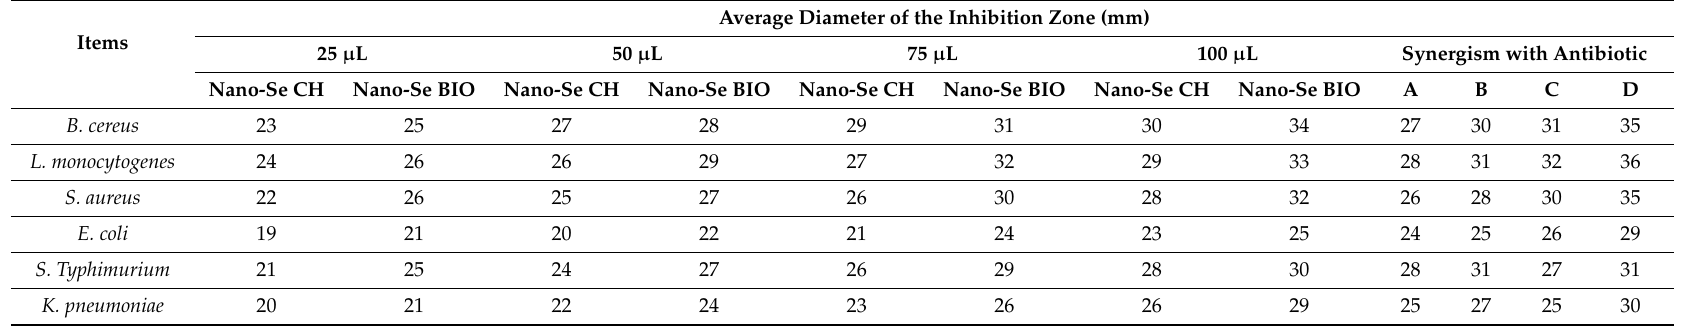
Table 1. In vitro anti-activity of nano-Se (CH or BIO) against several types of bacteria (inhibition zone, mm).